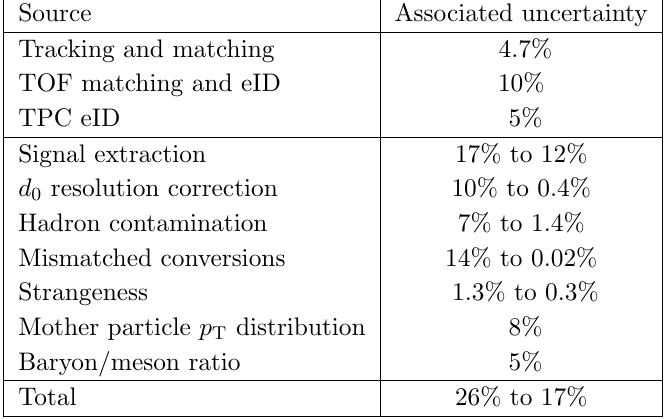
Table 2 . Systematic uncertainties in the Pb-Pb analysis. Individual sources of systematic uncer- tainties are p T dependent, which is reported using intervals. The lower and upper value of the interval, respectively, lists the uncertainty at p T = 1.3 GeV =c and p T = 8.0 GeV =c . The second group of entries in the table is related to the method used to extract the electrons from beauty- hadron